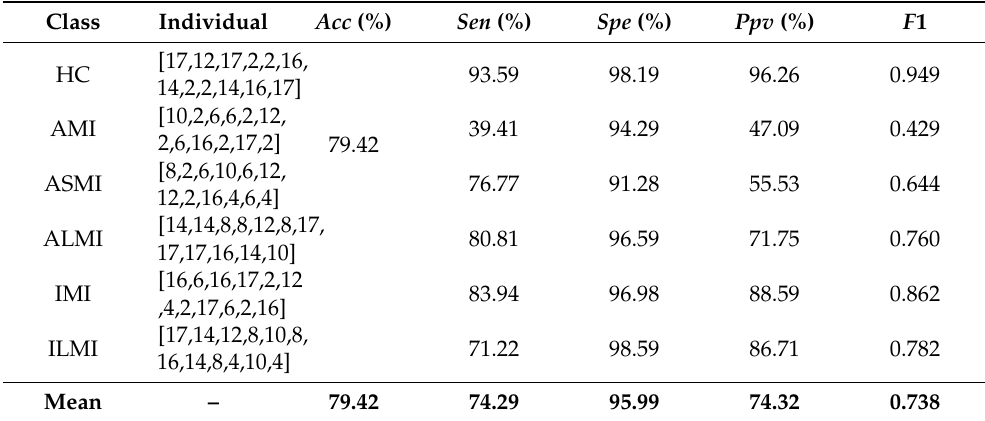
Table 4. The architectures and performances of the best fold in the five-fold cross